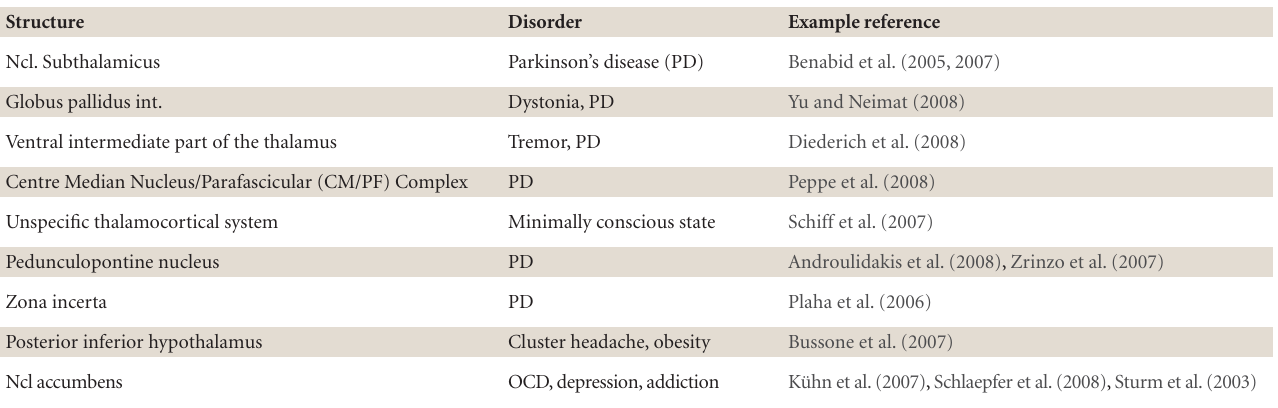
Table 1 | Brief summary of targeted brain structures and neuropsychiatric